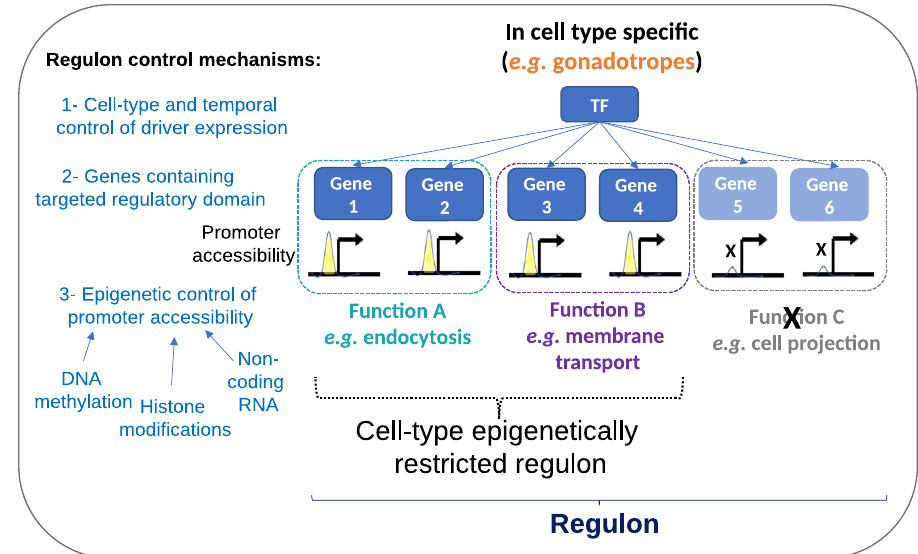
Fig. 9 Model of cell type-speci fi c regulon control mechanisms. Schematic of the proposed mechanisms for cell type-speci fi c regulation of regulon composition and function. Three layers of control shape the expression and composition of a cell type-speci fi c regulon and its biological function: cell type- speci fi c expression of the TF driver, presence of cis-regulatory domain at the target gene promoter, and epigenetic control of promoter